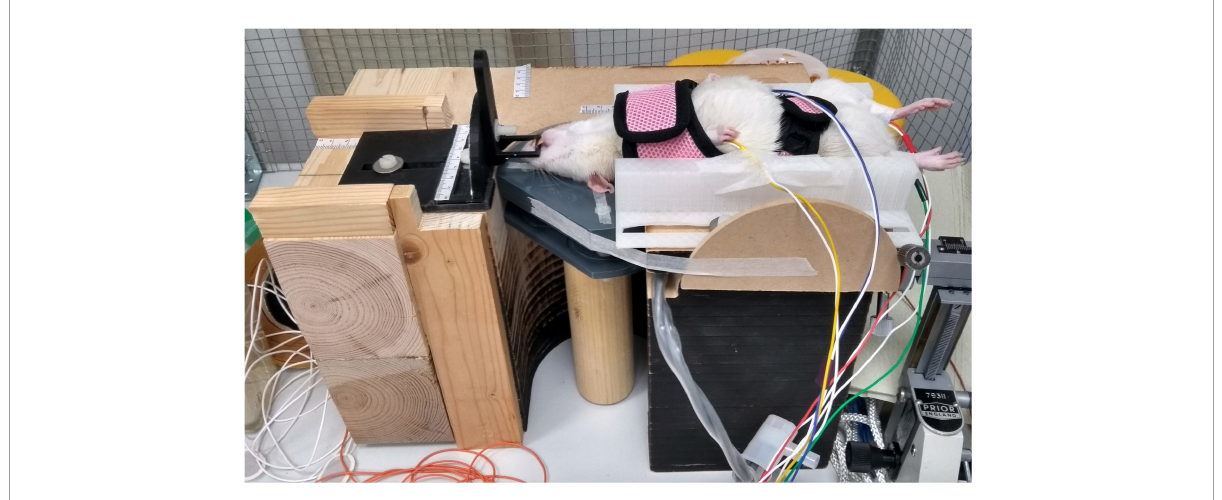
FIGURE2 Experimental set-up. A rat is fixed upside down on the holder. The head of the rat on the surface of the transcranial magnetic stimulation (TMS) coil is kept fixed with the help of the tooth mount. Electromyography is recorded from the limbs with bipolar needle